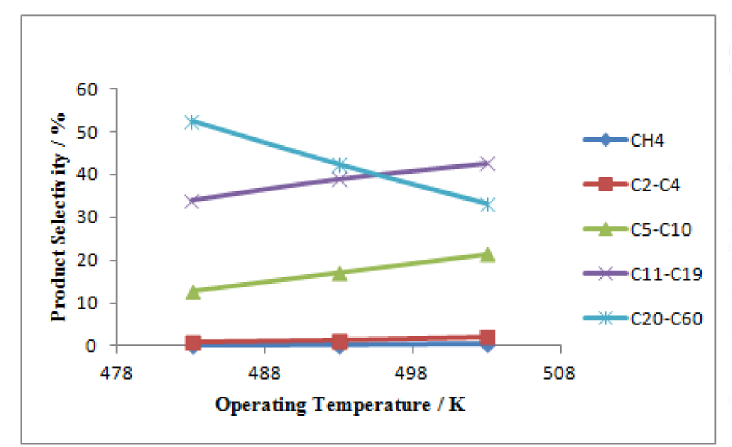
Figure 10. Influence of operating temperature on product selectivity; D t = 0.1 m, H = 2.5 m, V f = 5 m 3 /h, P = 20 bar, ε cat = 0.34.